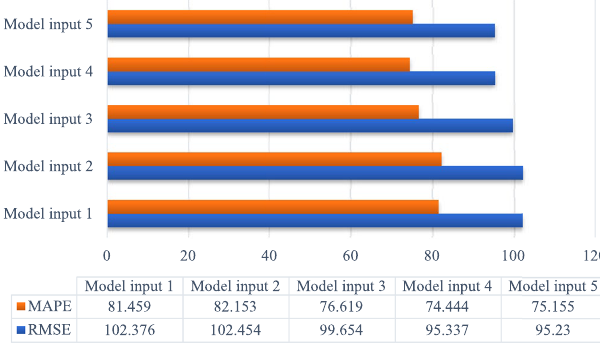
Figure 11. Comparison of prediction effects under different model